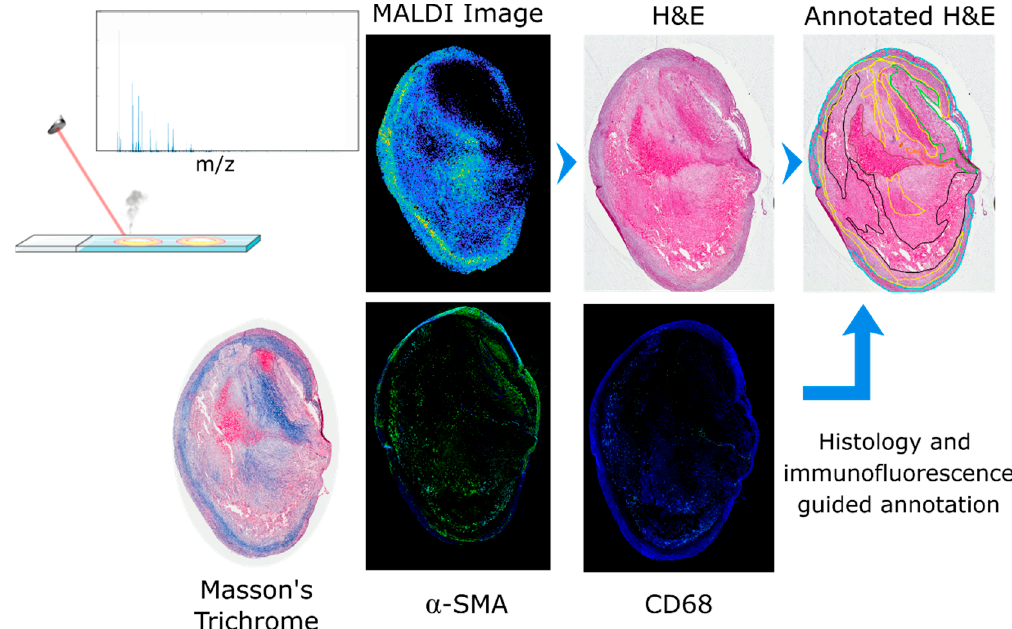
Figure 1. Annotation workflow for definition of regions. After MALDI MSI data acquisition, any residual matrix was removed and the tissue section histologically stained with hematoxylin and eosin. A consecutive section was stained with Masson’s trichrome to detect collagen (in blue). Two additional consecutive tissue sections were used for immunofluorescence of α -SMA and CD68 to detect VSMCs and macrophages, respectively. The histological image was then annotated based on the information gained from Masson’s trichrome and the immunofluorescence images; seven regions were defined: calcification (purple), hemorrhage (brown), lipid-necrotic core (black), collagen (yellow), macrophages (orange), outer VSMCs (cyan) and inner VSMCs (green).